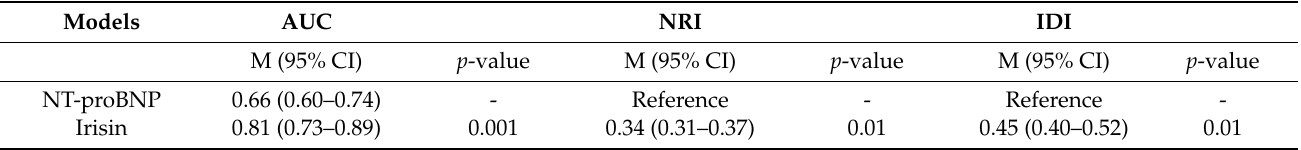
Table 3. Comparison of the discriminative powers of NT-proBNP and irisin for predicting poor glycemic